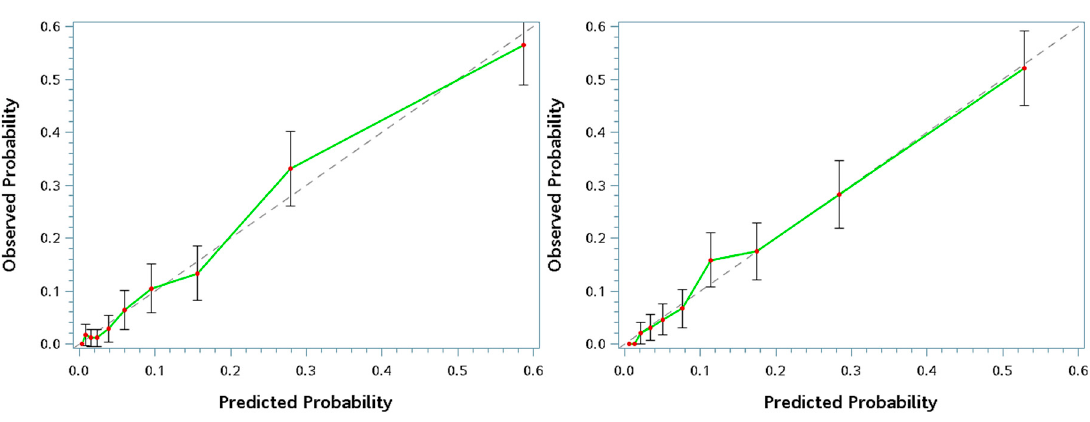
Figure 2. Decile calibration plots for screening the presence of metabolic syndrome. Left panel plots the convenient model, and the right panel plots the final model. The discontinuous line is the predicted probability, while the solid green line is the observed probability.